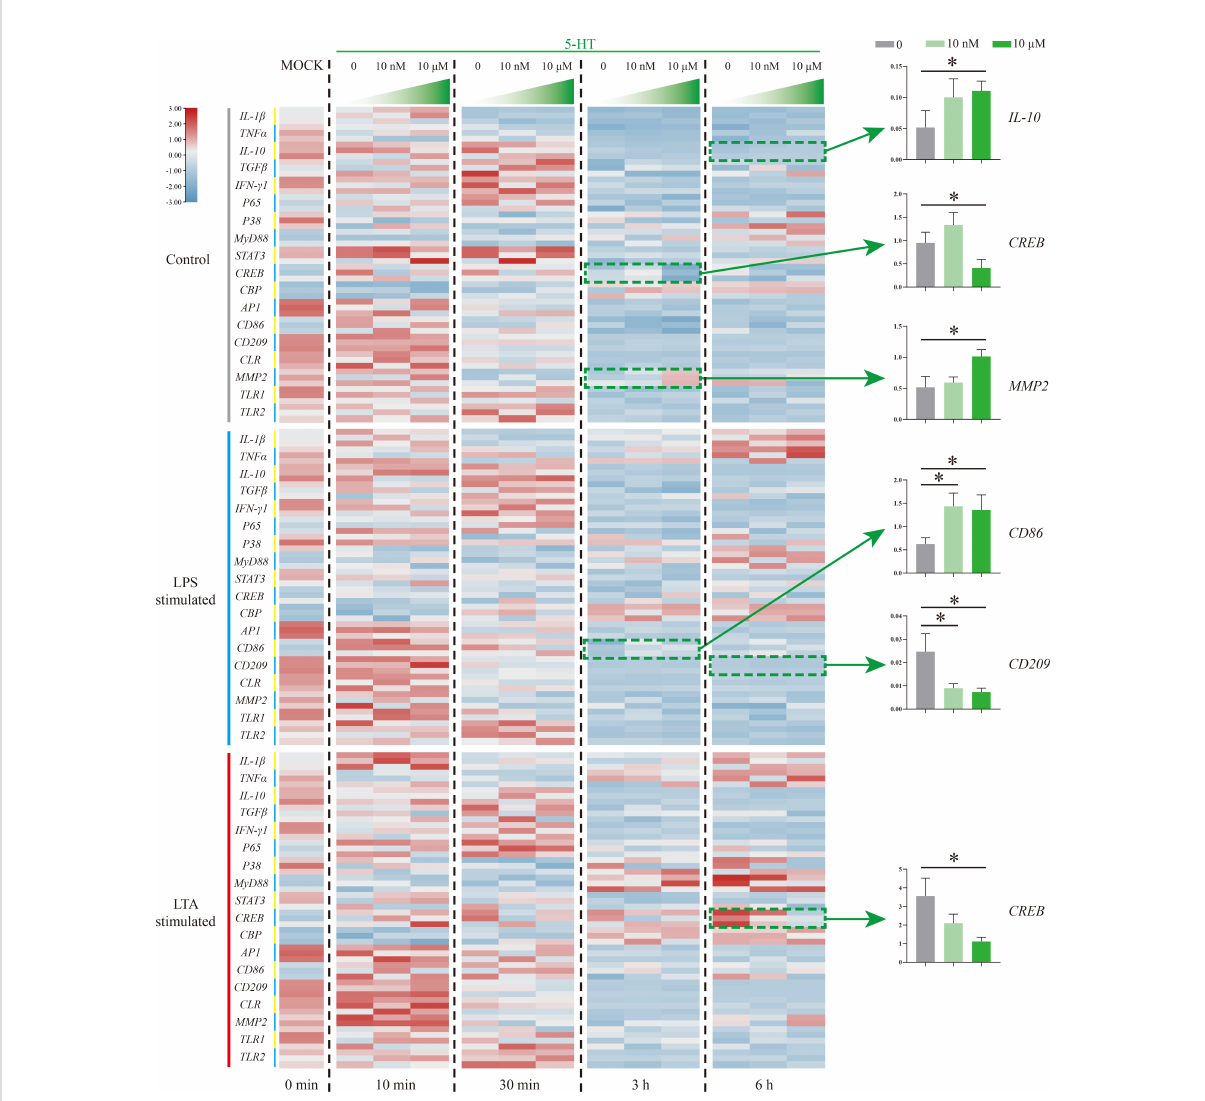
FIGURE 5 The expression patterns of numerous immune-related genes detected via qRT-PCR at different time points among three model groups with different concentrations of 5-HT treatment. n = 3. The signi fi cant difference analysis at each time point was performed via student ’ s t-test (compared in pairs) and the all signi fi cant different results were further displayed by the histograms on the right as well as indicated with asterisks ( p < 0.05). See Table S2 for the expression details of candidate